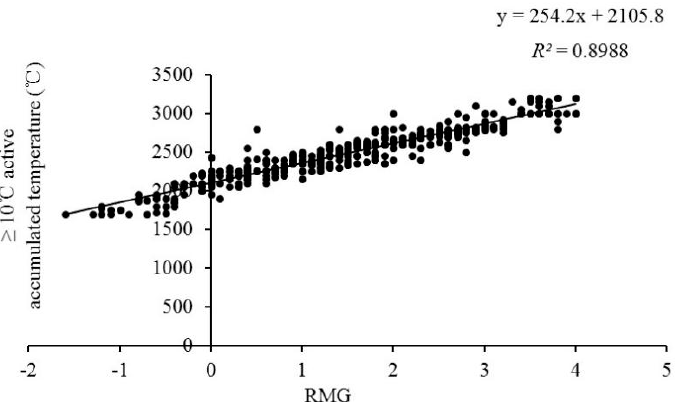
Figure 2. Linear regression of the association between the AAT of soybean cultivars growth period and maturity groups. Note: − 2, and − 1 represent MG 000, and MG 00, respectively. Table 1. ≥ 10 °C active accumulated temperature and crop heat units in different maturity groups.